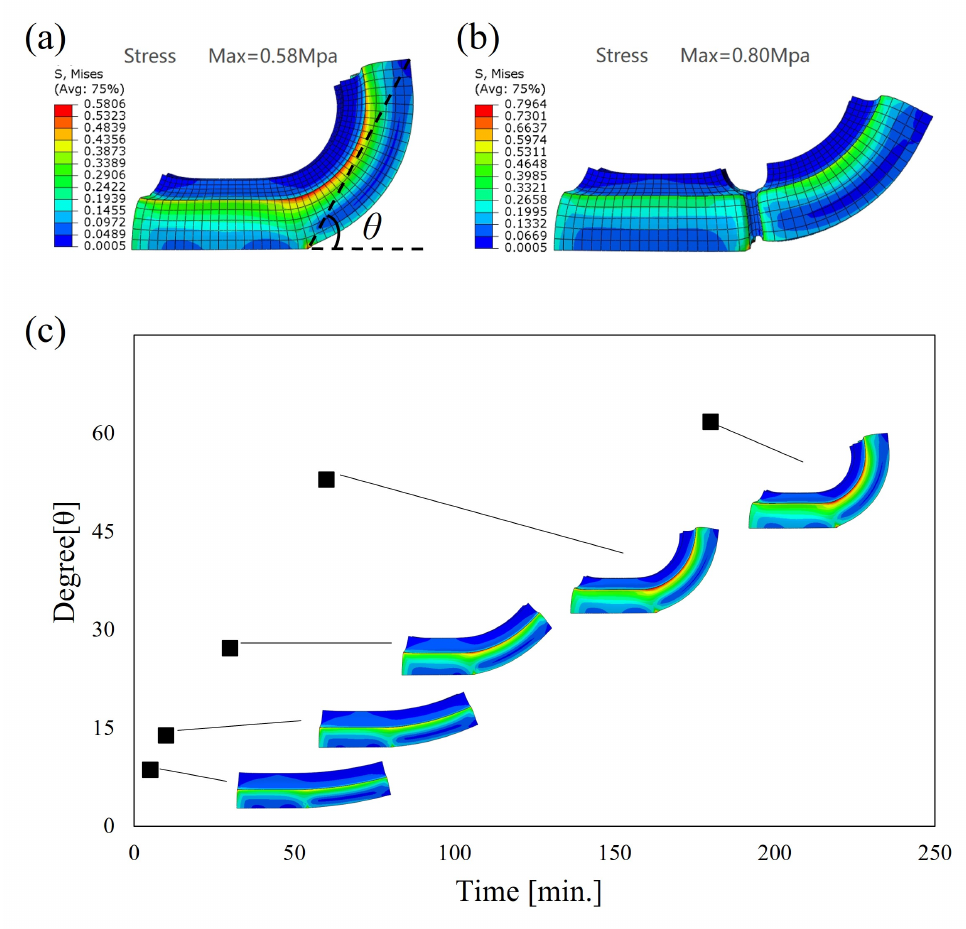
Figure 10. FE simulation results of: ( a ) the two identical layer model, ( b ) the model with a hinge structure, and ( c ) the bending deformation in different time